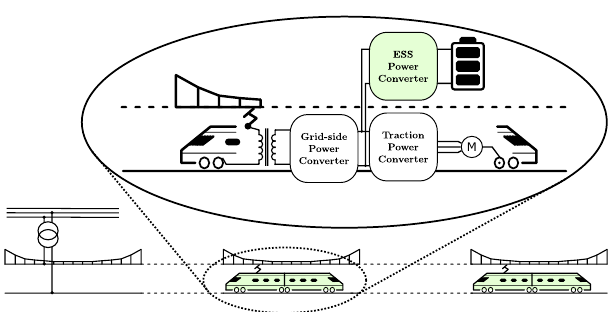
Figure 3. Illustration of the on-board train